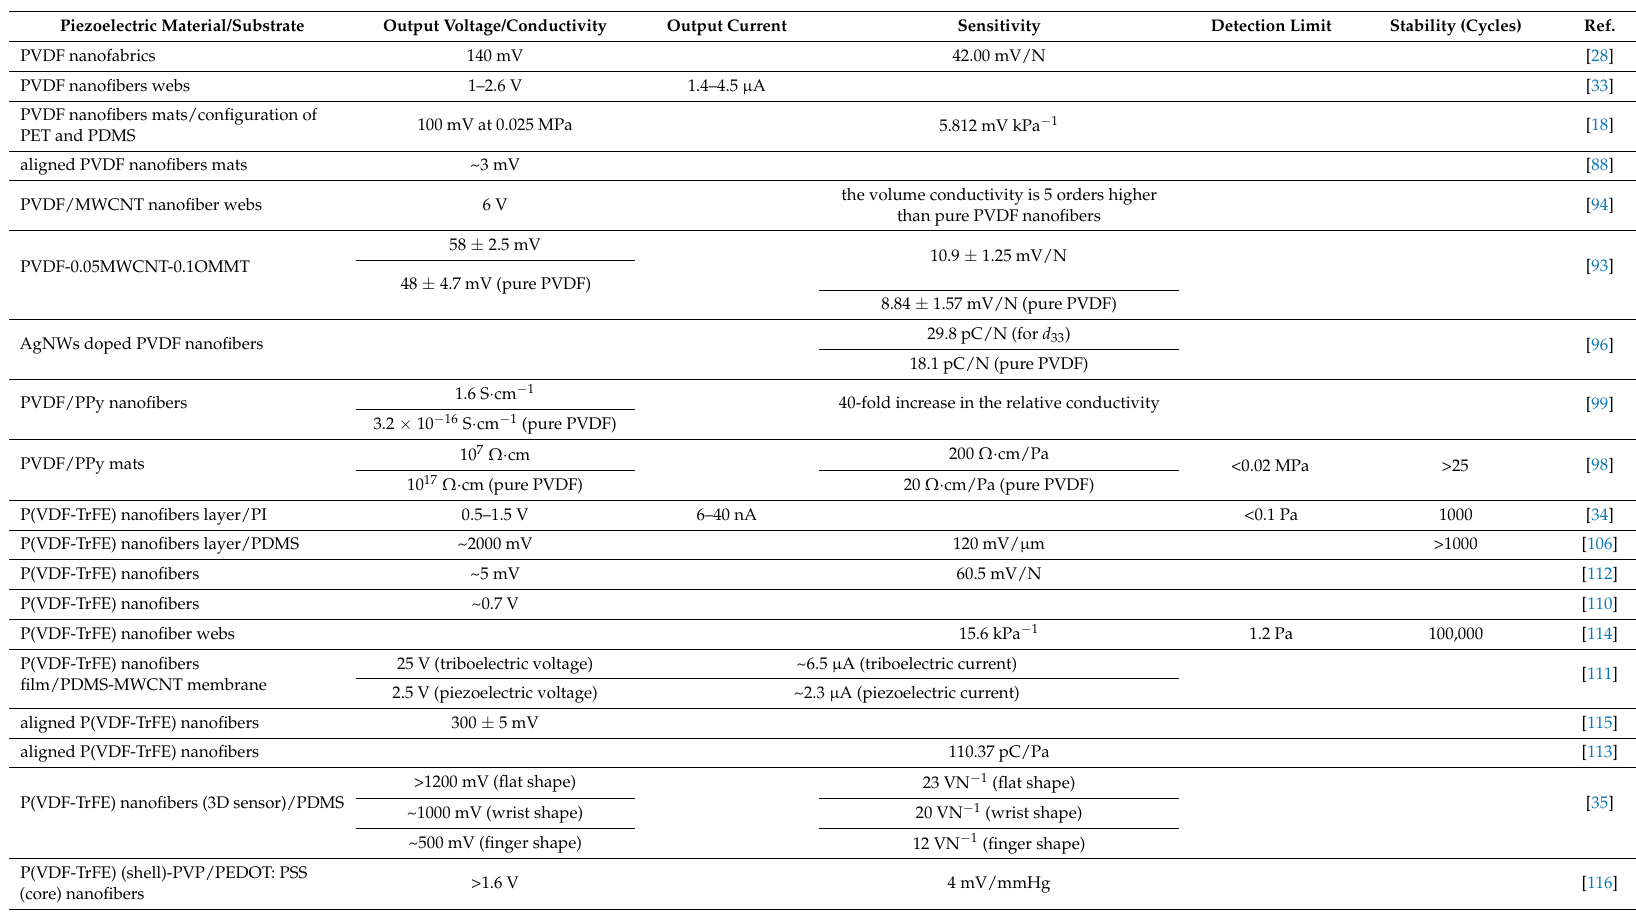
Table 1. The piezoelectric properties of PVDF, P(VDF-TrFE) and their nanocomposite via